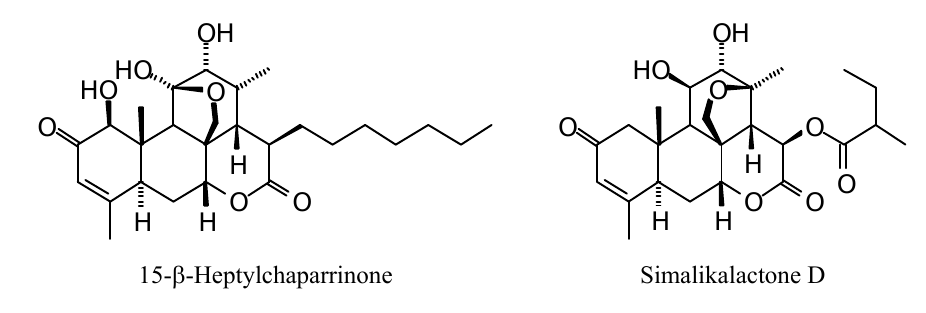
Figure 22. Quassinoids examined in this work.